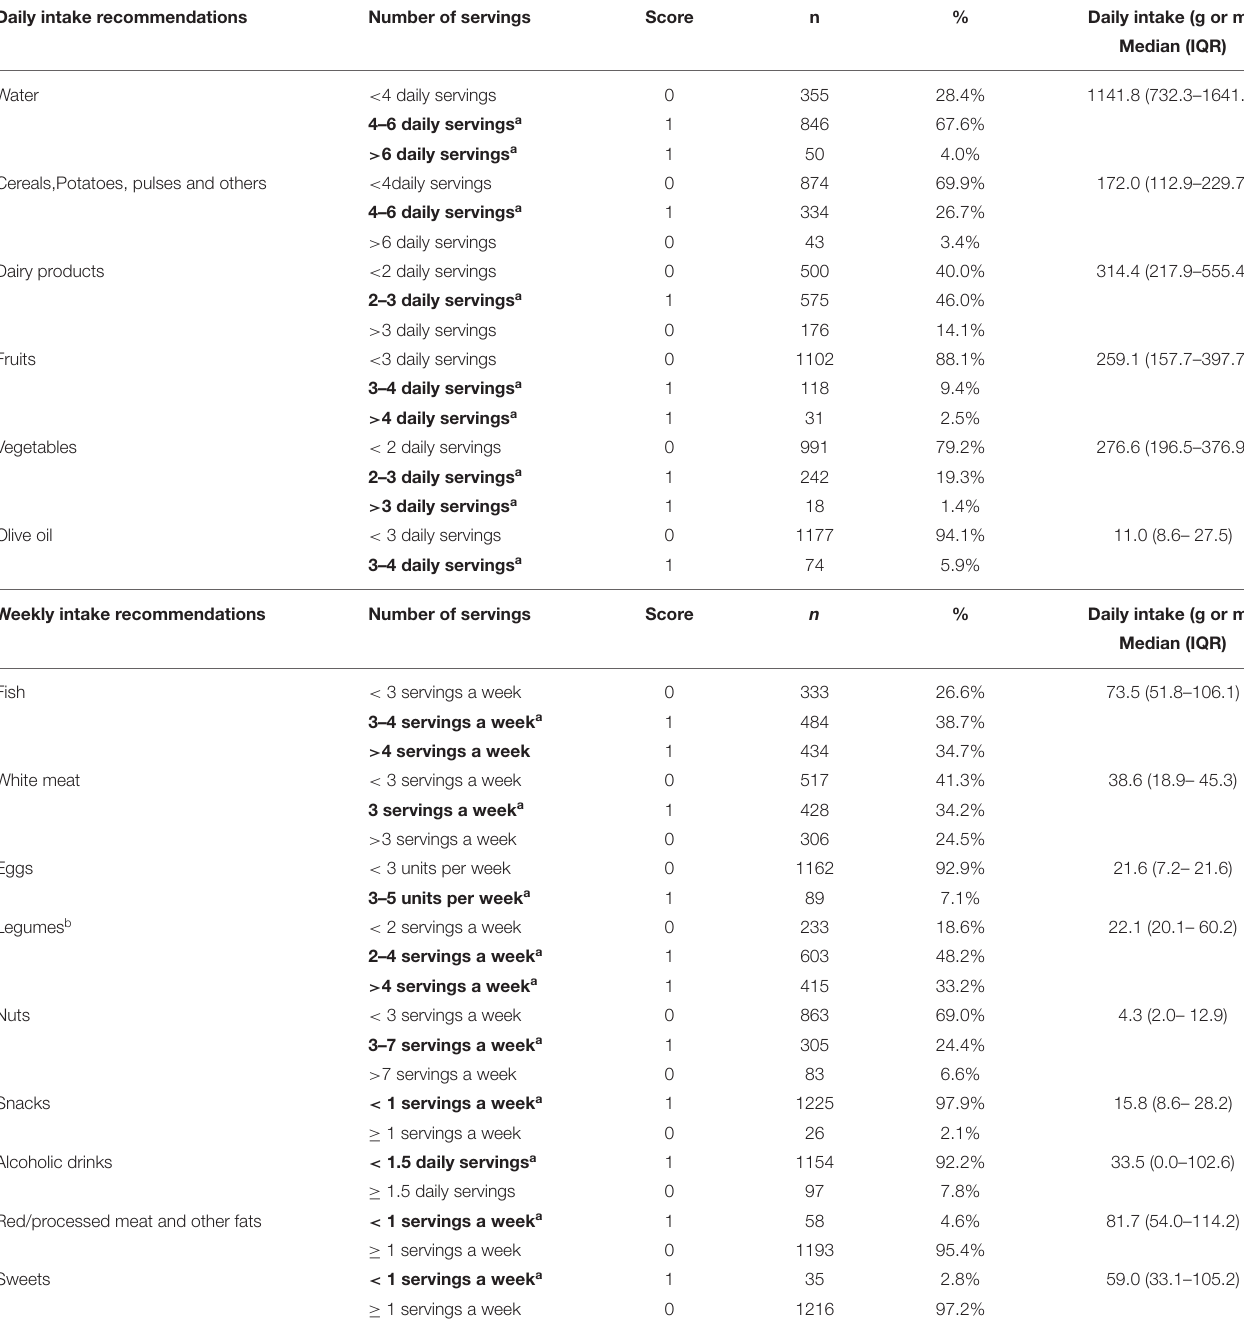
TABLE 3 | Score and adherence to the SENC food–based dietary